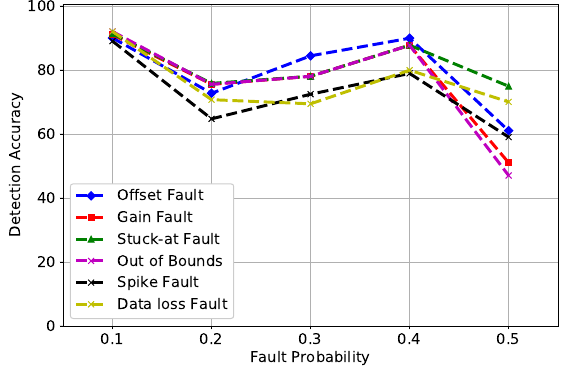
Figure 6. CNN detection accuracy of fault